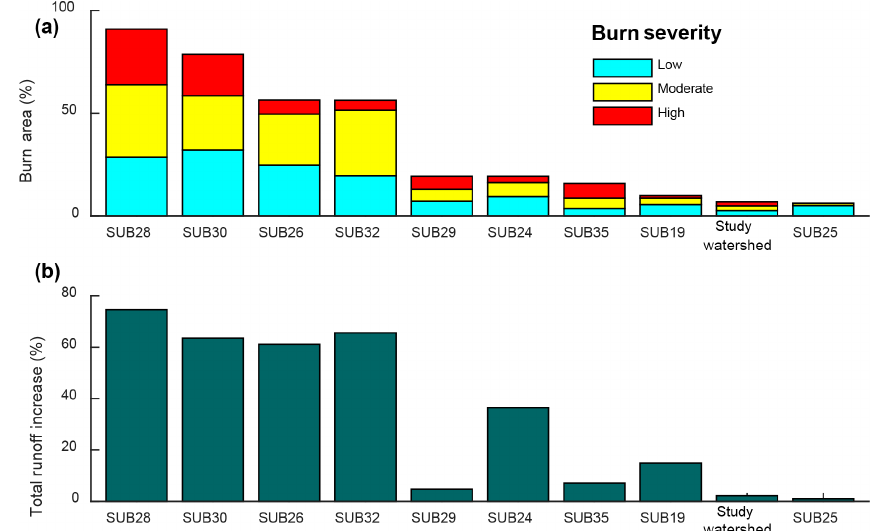
Figure 6. Burn severity distribution (a) and average annual total runoff percent increase between the no-wildfire and fire scenarios (b) . Results are shown for the burned sub-watersheds as well as for the entire study watershed arranged in descending order from left to right based on total percent burned area.